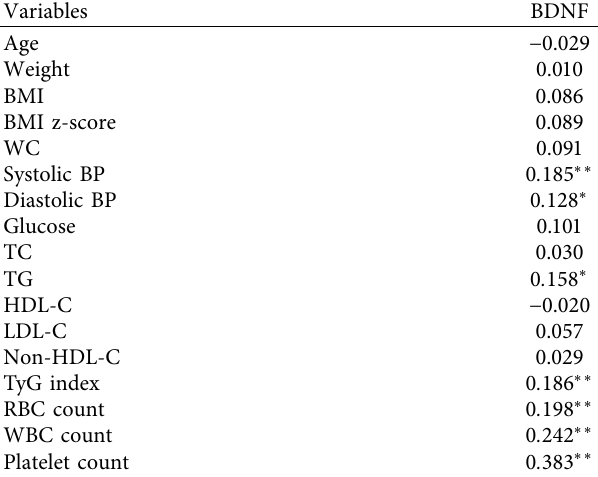
Table 2: Correlation coefcients of brain-derived neurotrophic factor concentration with other parameters in all